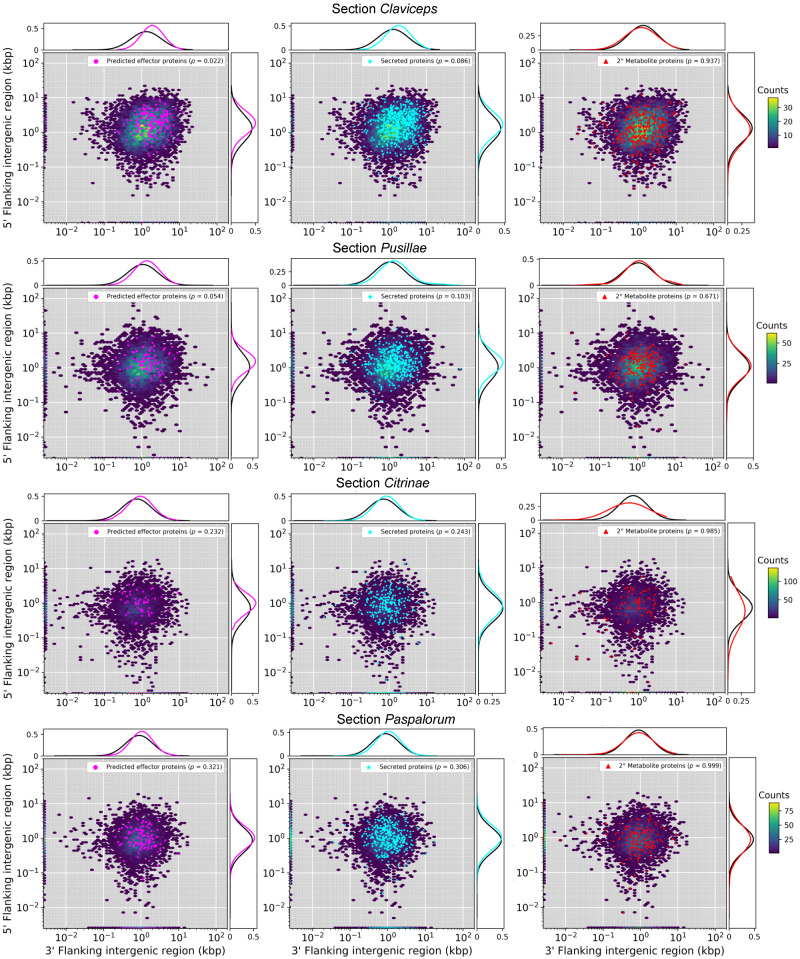
Gene density as a function of flanking 5' and 3' intergenic region size (y- and x axis) of representative isolates of each of the four sections within the Claviceps genus; C. purpurea 20.1 (sect. Claviceps), C. maximensis CCC398 (sect. Pusillae), C. paspali RRC1481 (sect. Paspalorum), and C. citrina (sect. Citrinae). Colored hexbins indicate the intergenic lengths of all genes with color code indicating the frequency distribution (gene count) according to the legend on the right. Overlaid markers indicate specific gene types corresponding to legends in the top right within each plot. Line graphs (top and right of each plot) depict the frequency distributions of specific gene types (corresponding legend color) and all other genes not of the specific type (black). For visualization purposes, the first genes of contigs (5′ end) are plotted along the x axis and the last gene of each contig (3′ end) are plotted along the y axis. For information on statistical test, see Methods and for plots of all remaining isolates see supplementary figure S10, Supplementary Material online.